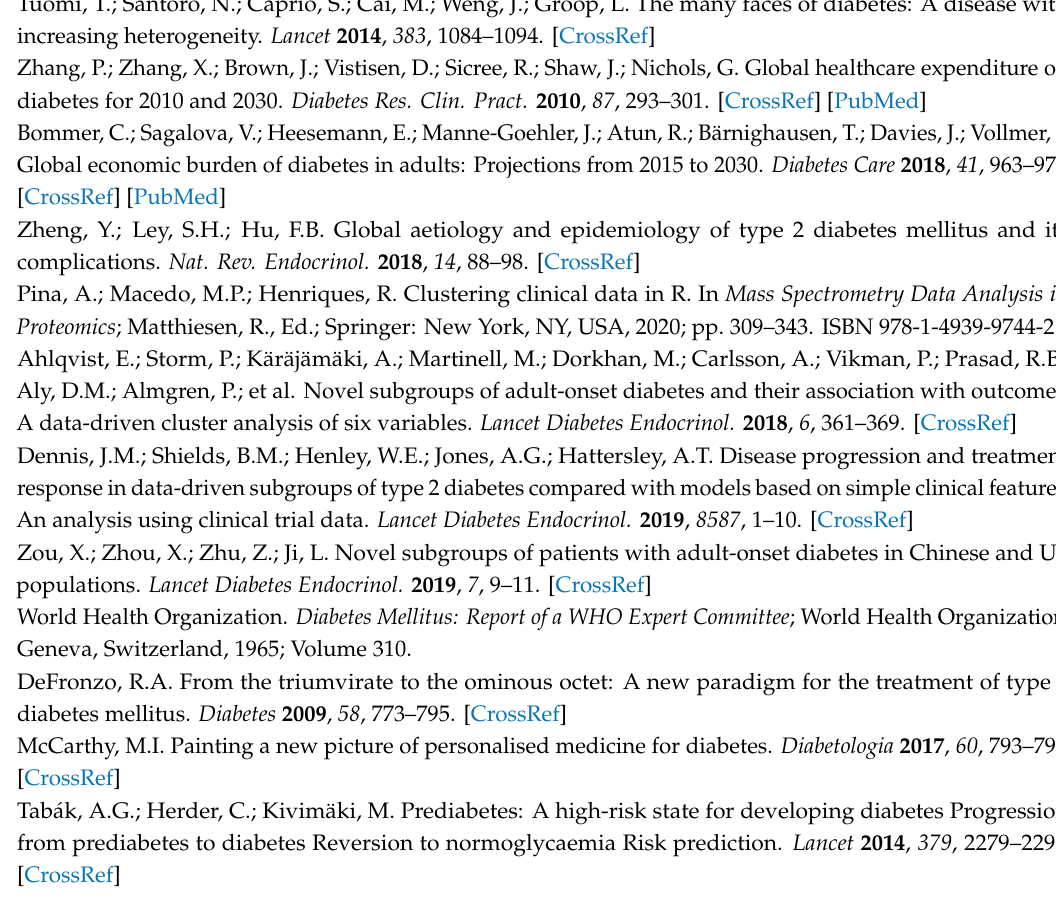
Figure S1: Self Organizing Map (SOM) neighbor distance plot ( a ) and quality plot ( b ) of the 27 SOM units; Figure S2: Clusters profiling for the male population; Figure S3: Clusters profiling for the female population; Figure S4: Clusters profiling for K = 27, males; Figure S5: Clusters profiling for K = 27, females; Table S1: Indexes formulas and calculations of the parameters used to profile the